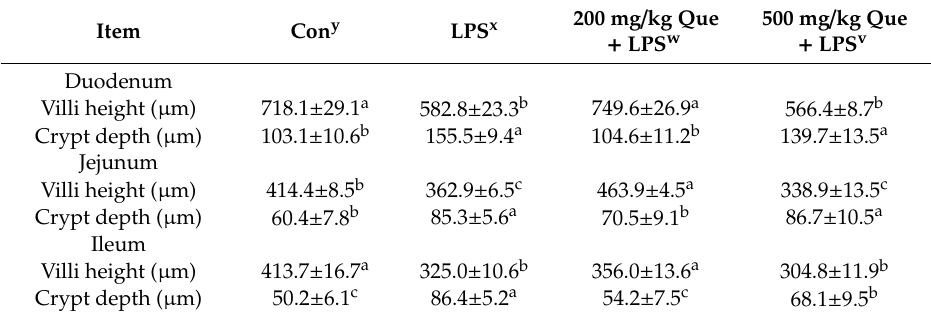
Table 3. Intestinal morphology of broiler chickens in the four groups. z